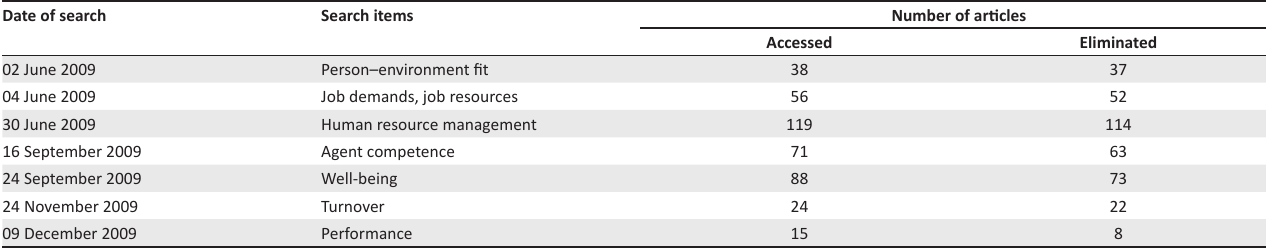
TABLE 1: Literature search tracking